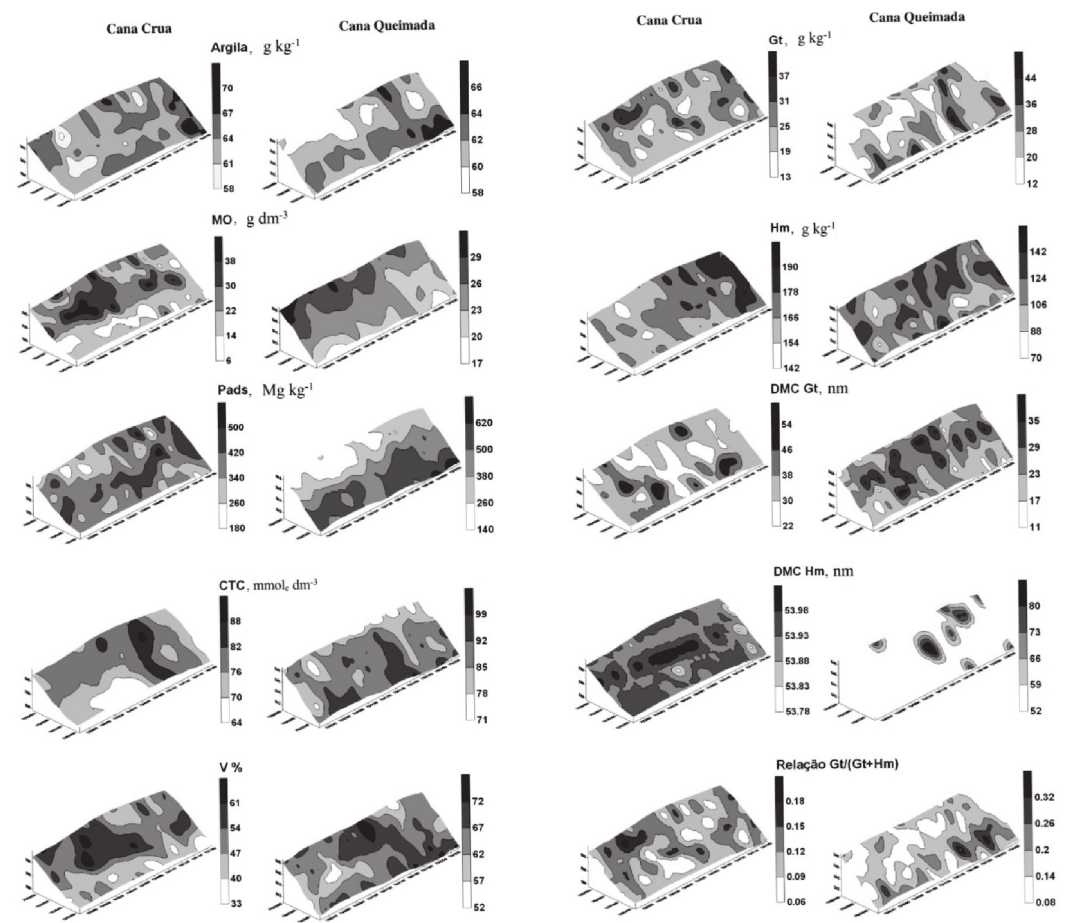
Figura 3. Mapas de isolinhas dos atributos químicos nas áreas de cana crua e cana queimada. MO: matéria orgânica; P ads : fósforo adsorvido. Hm: hematita; Gt: goethita; e DMC: diâmetro médio do